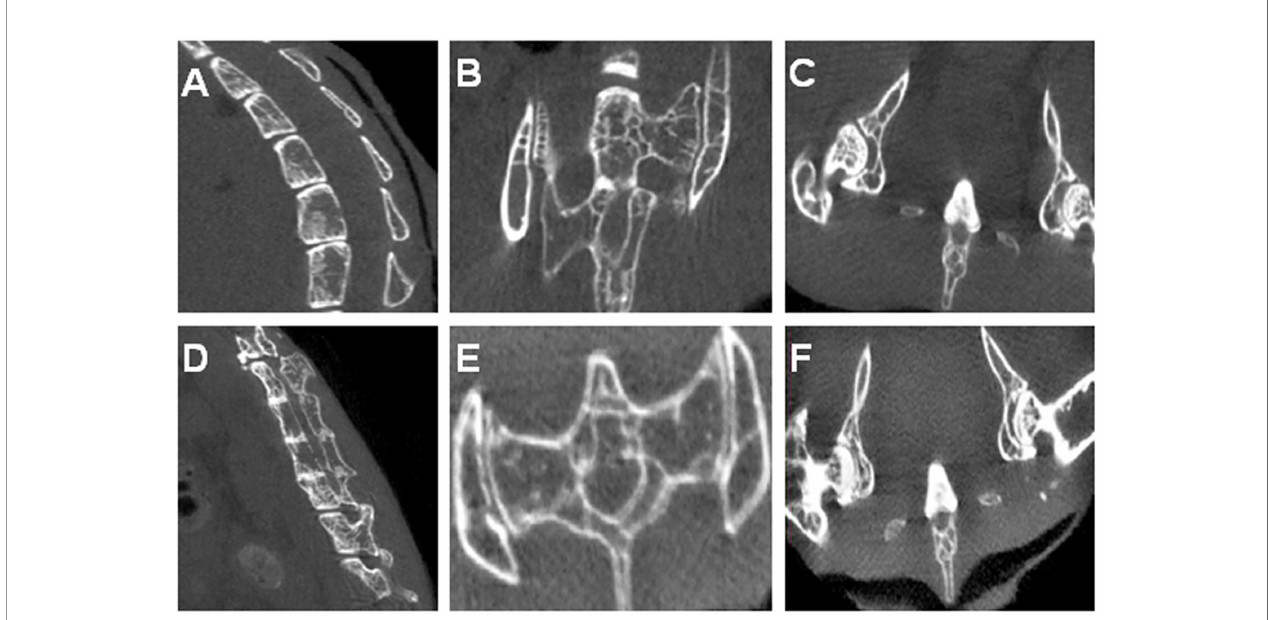
FIGURE 3 | Micro-CT results: (A) A control mouse showing physiological spinal curvature, intact bone, smooth articular surface, and substantial intervertebral space; (B) SIJs of a control mouse; (C) Hip joints of a control mouse; (D) Spine of an PGA-induced model mouse showing loss in curvature, irregular and sclerotic articular surfaces, and narrowing of intervertebral discs. Some of the vertebral bodies appeared fused; (E) SIJs of an PGA-induced model mouse showing irregular joint surfaces; (F) Hip joints of an PGA-induced model mouse showing irregular joint surfaces and narrowing of joint spaces.